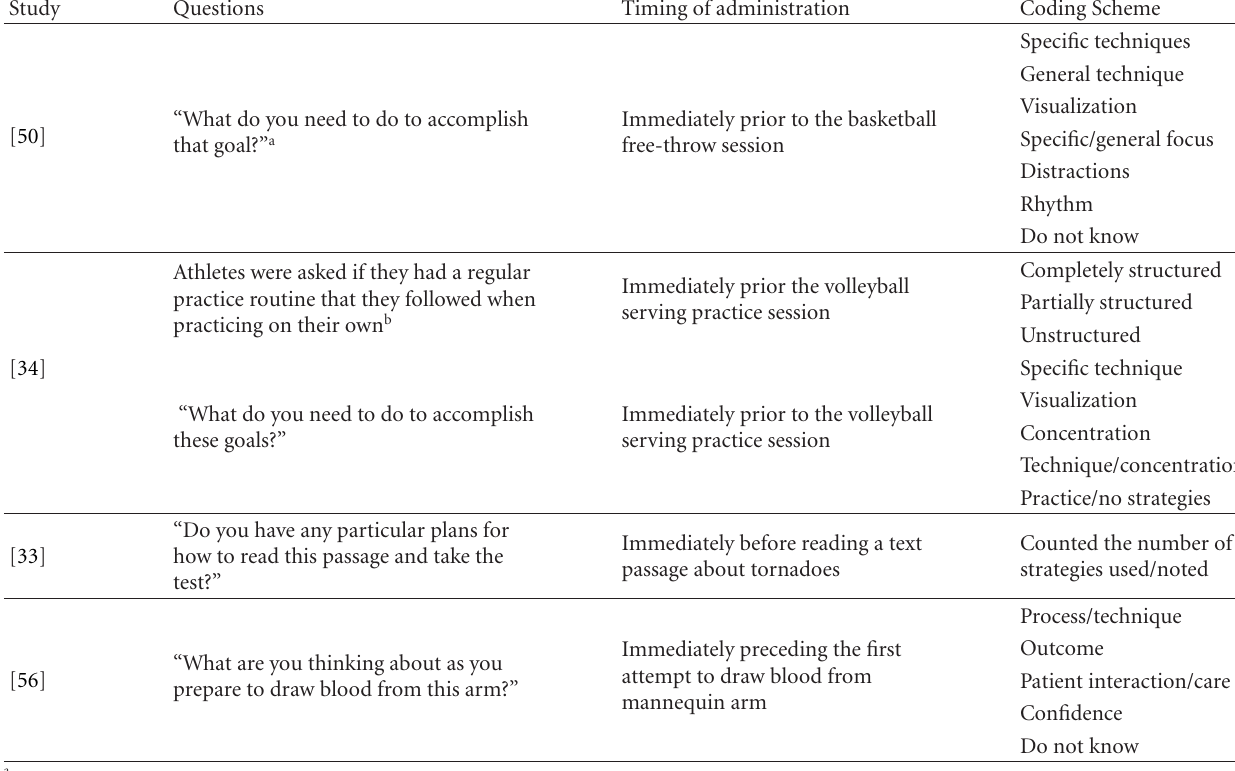
Table 3: Examples of strategic planning microanalytic questions, administration sequence, and coding scheme.